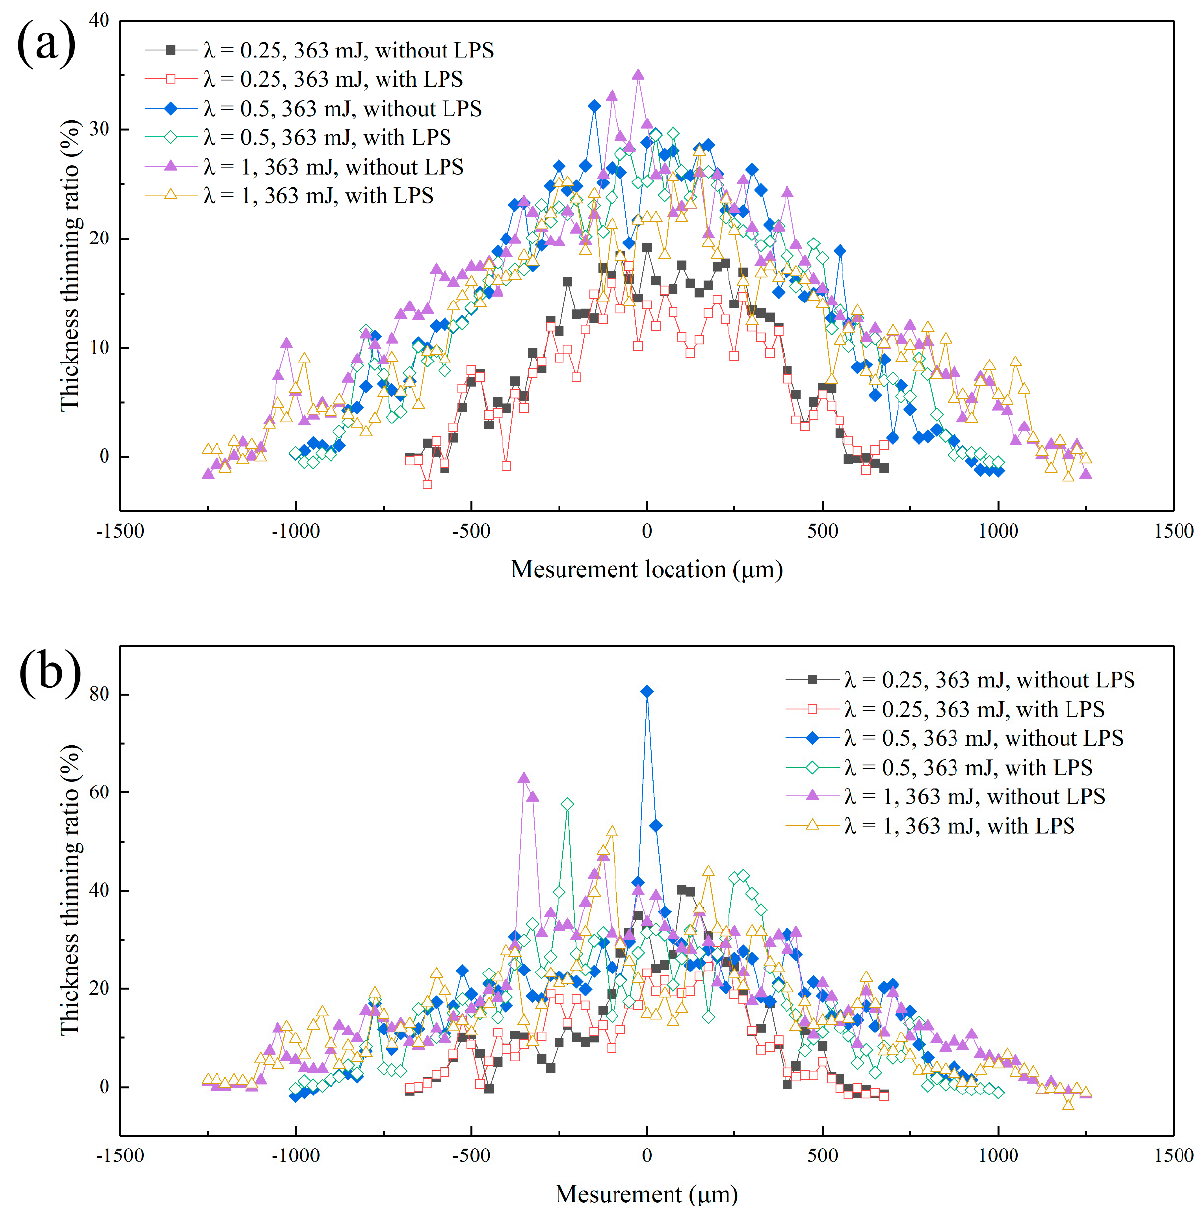
Figure 13. Thickness thinning rate of bulging samples with different molds under laser pulse energy of 363 mJ. ( a ) Fine-grained samples (450 ◦ C annealed); ( b ) coarse-grained samples (650 ◦ C annealed). In this section, the maximum thickness thinning rate under different laser pulse energy is proposed to further explore the influence of mold characteristic size on the thickness thinning of bulging samples, and the specific values obtained are shown in Figure 14. It is found that the maximum thickness thinning rate of bulging samples is 87.7% (fine-grained samples, λ = 0.25, laser pulse energy of 725 mJ) and 80.6% (coarse grained samples, λ =